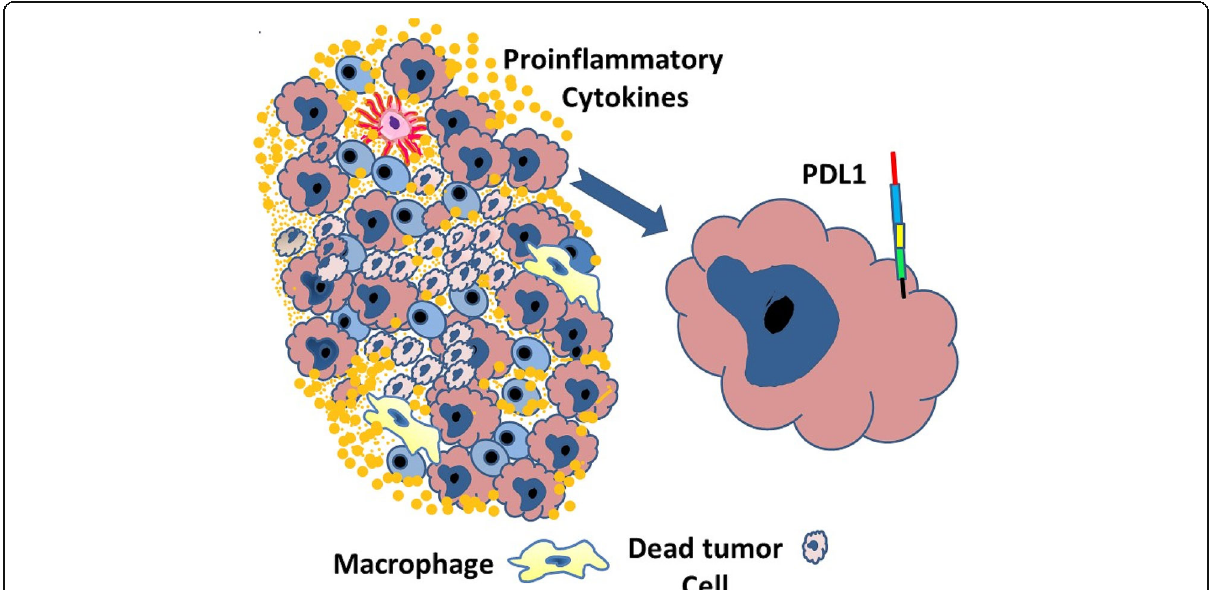
Fig. 7 Interaction of PD-L1 on cancer cells with PD-1 on the lymphocytes results in inactivation of the lymphocytes and increased numbers of Tregs ,thus providing an immune inhibitory